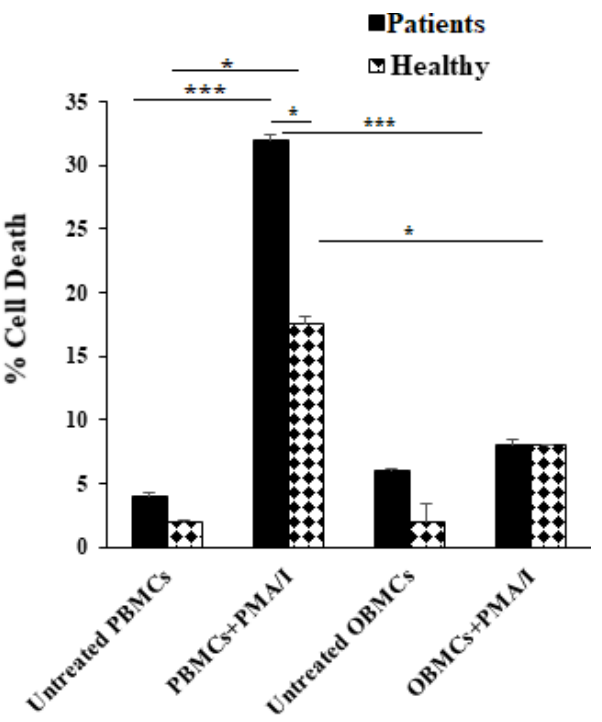
Figure 2. Higher levels of cell death were observed in periodontitis patients’ PBMCs when compared to those from healthy individuals. Mononuclear cells obtained from peripheral and oral blood of healthy individuals and periodontitis patients were treated with PMA (10 ng/mL) + ionomycin (10 ng/mL) for 10–14 h. The samples were then washed and propidium iodide (30 µg/mL) was added to each sample. The percentages of dead cells were determined by flow cytometric analysis. PBMCs and OBMCs were obtained from the same donors. One of four representative experiments is shown in this figure. *** ( p value <0.001), * ( p value 0.01–0.05). 3.5. Increased TNF- α Secretion Was Observed from OBMCs of Periodontitis Patients When OBMCs and PBMCs of periodontitis patients were left untreated or treated with IL- 2 or IFN- γ or PMA/I, and the levels of TNF- α secretion were determined after 12 to 18 h. Higher secretion of TNF- α was observed from OBMCs when compared to PBMCs of per- iodontitis patients (Figure 3A). IFN- γ treatment increased TNF- α secretion moderately by patient OBMCs whereas it induced significant levels of secretion by the patient PBMCs (Figure 3A). Although there was a moderate increase in TNF- α release by IFN- γ treated OBMCs obtained from patient and healthy donors, the increase was not statistically sig- nificant (Figure 3A). The lack of increase in TNF- α by IFN- γ could be due to higher basal activation of OBMCs in patients. The levels of TNF- α secretion between PMA/I-treated PBMCs and OBMCs plateaued since PMA/I activates lymphocytes in both cell popula- tions maximally (Figure 3A). Next, we compared the TNF- α secretion in OBMCs obtained from healthy individuals and periodontitis patients. We observed increased secretion of TNF- α in OBMCs from periodontitis patients with and without IL-2 or IFN- γ treatment (Figure 3B). These results demonstrated the increased functional activities of mononuclear cells in oral blood as compared to peripheral blood of periodontitis patients. Furthermore, periodontal disease found to be associated with increased TNF- α secretion in oral blood immune cells.